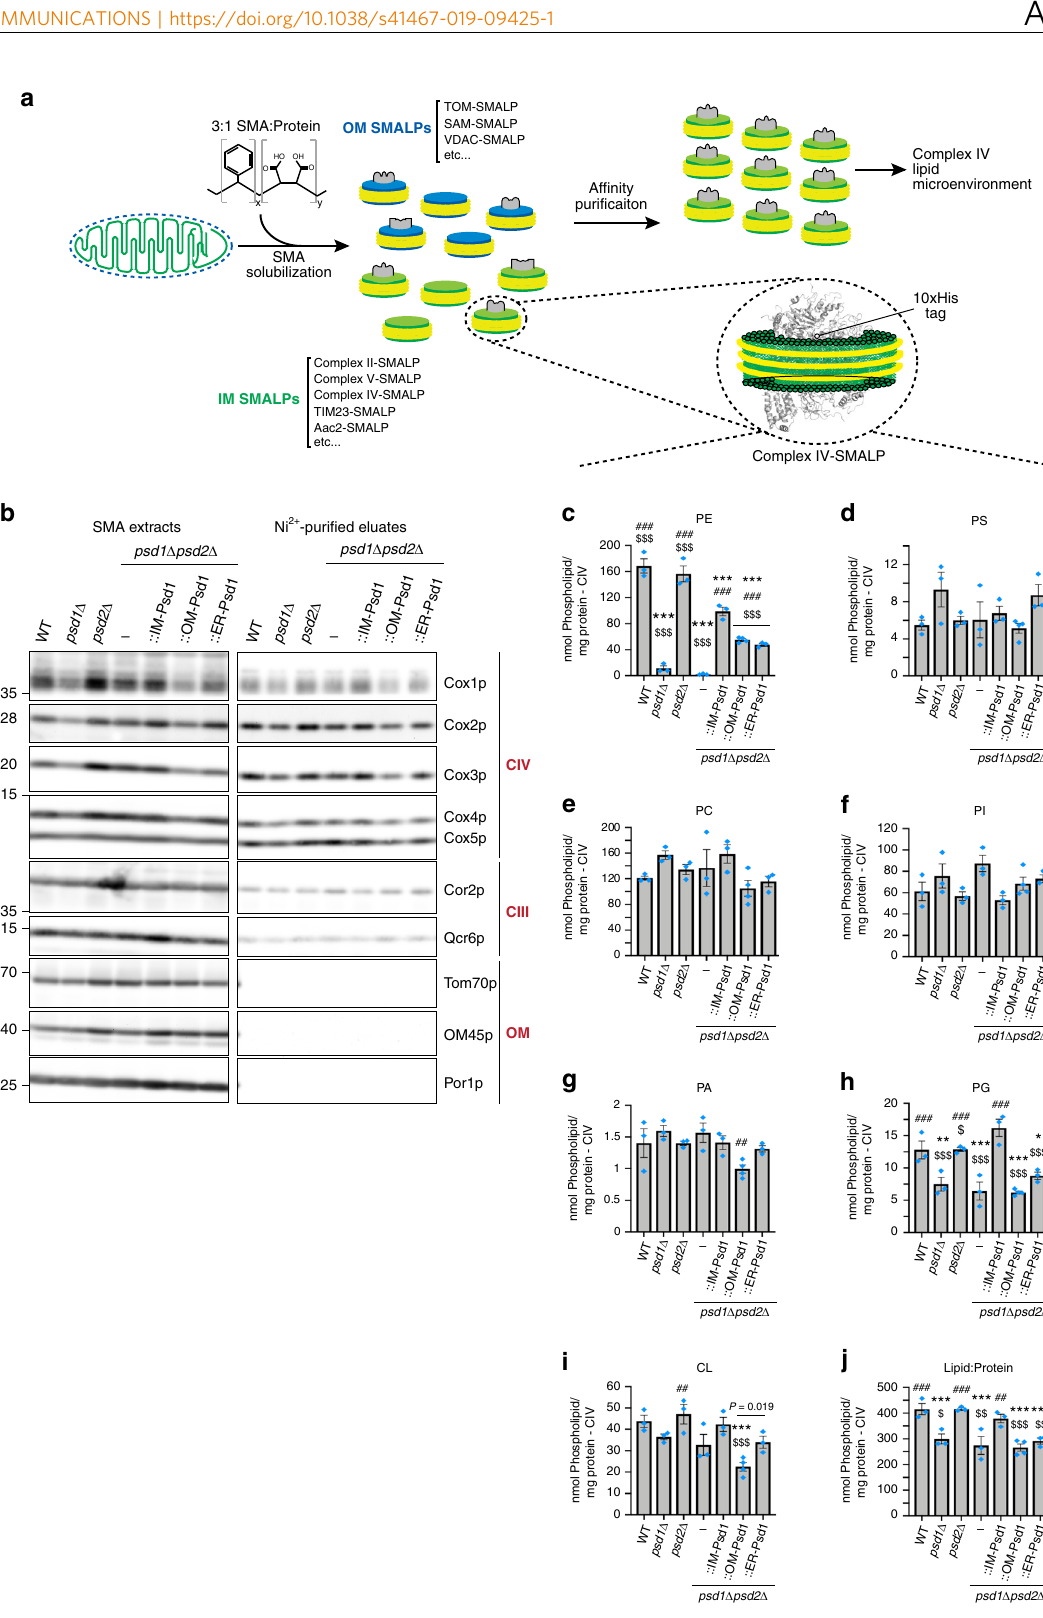
membrane protein complexes and their adjacent